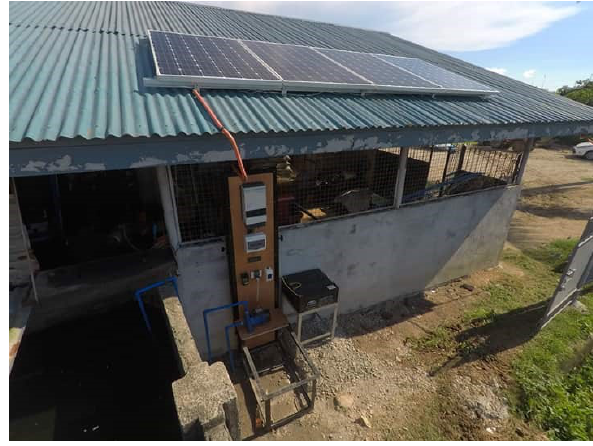
Figure 3: Developed Solar-Powered Water Pump as installed in a small farm in Bataan